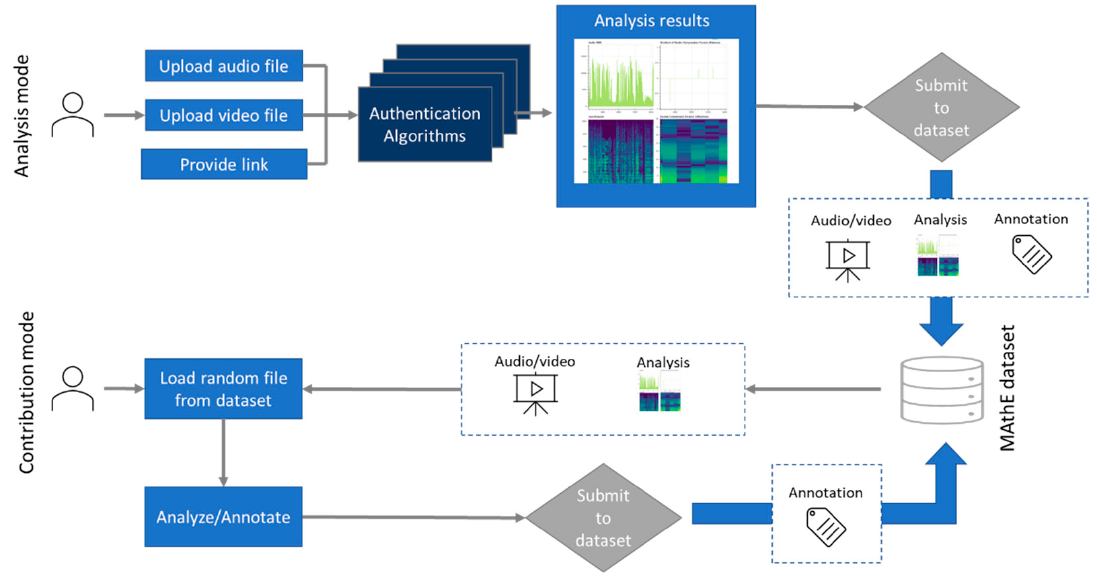
Figure 1. The MAthE AudioVisual Authentication framework and functionality.